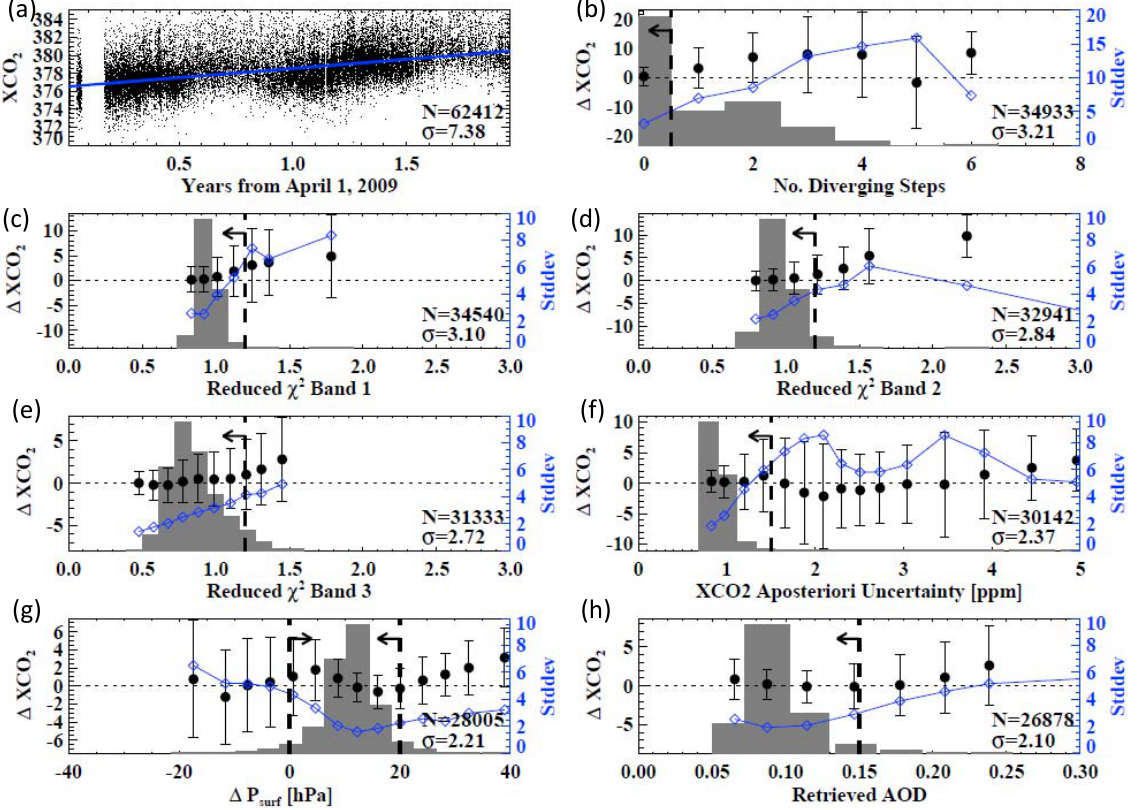
Fig. 8. Derivation of the post-processing filters applied to ACOS B2.8 data products. (a) X CO estimates from all cloud-free soundings 2 collected over land at latitudes between 20 ◦ S and 70 ◦ S between 4 April 2009 and 19 April 2011. The blue line indicates the secular trend in X CO . Other panels show a histogram of the distribution of soundings as a function of the filtering variable (grey boxes) as well as: (i) 2 the difference between the ACOS GOSAT X CO estimates and a spatially-invariant X CO background derived from TCCON data collected 2 2 at latitudes between 20 ◦ S and 70 ◦ S, 1 X CO , (black points with 1- σ error bars) for each bin in the histogram; (ii) the standard deviation in 2 1 X CO for each bin in the histogram (blue diamonds and blue line, quantified as Stddev on the right-hand ordinate), and (iii) the range of 2 values that pass the filter (dashed vertical lines with horizontal arrows). The number of points that passes the each filter, N, and the standard deviation in 1 X CO for this ensemble, σ , are shown in the lower right of each panel. The filtering variables include the number of diverging 2 steps in the retrieval (b) , the reduced χ 2 for the fit in the 3 SWIR bands (c–e) , the X CO a posteriori uncertainty (f) , the difference between 2 the retrieved and a priori (ECMWF) surface pressure, 1P surf (g) , and the total aerosol optical depth at 0.755µm, AOD. The panels are shown with the cumulative effect of each previous filter applied, so that only soundings passing all previous filters are used in any given